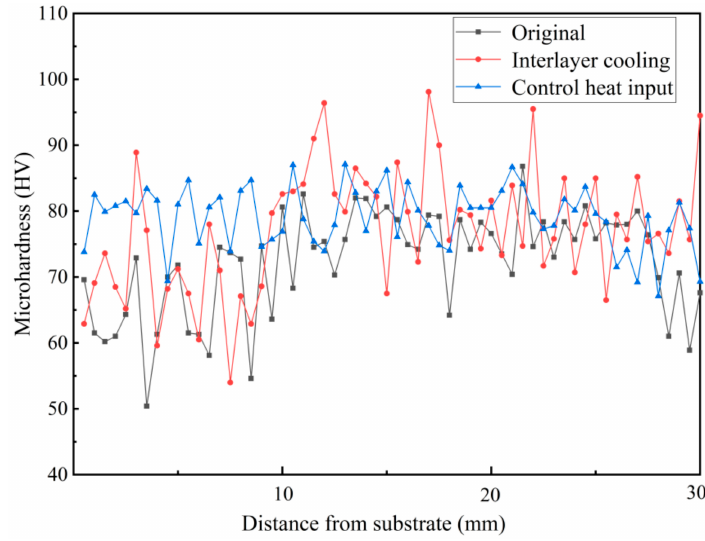
Figure 11. Microhardness of deposited